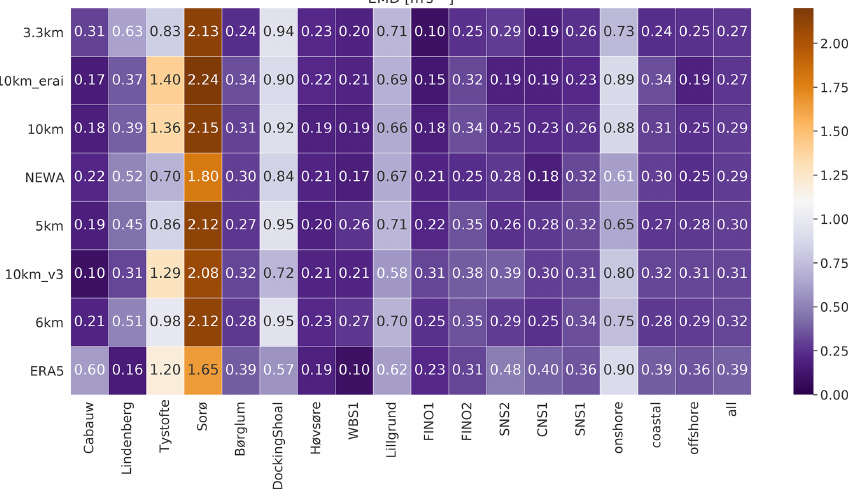
Figure 6. Earth mover’s distance (EMD; ms − 1 ) between simulations and measurements for the various experiments in Table 1 and reanal- yses. The darkest purple colours are the best results; the darkest brown is the worst. The rows are sorted by the column median all, with the most accurate results on the top and the least accurate results on the bottom of the